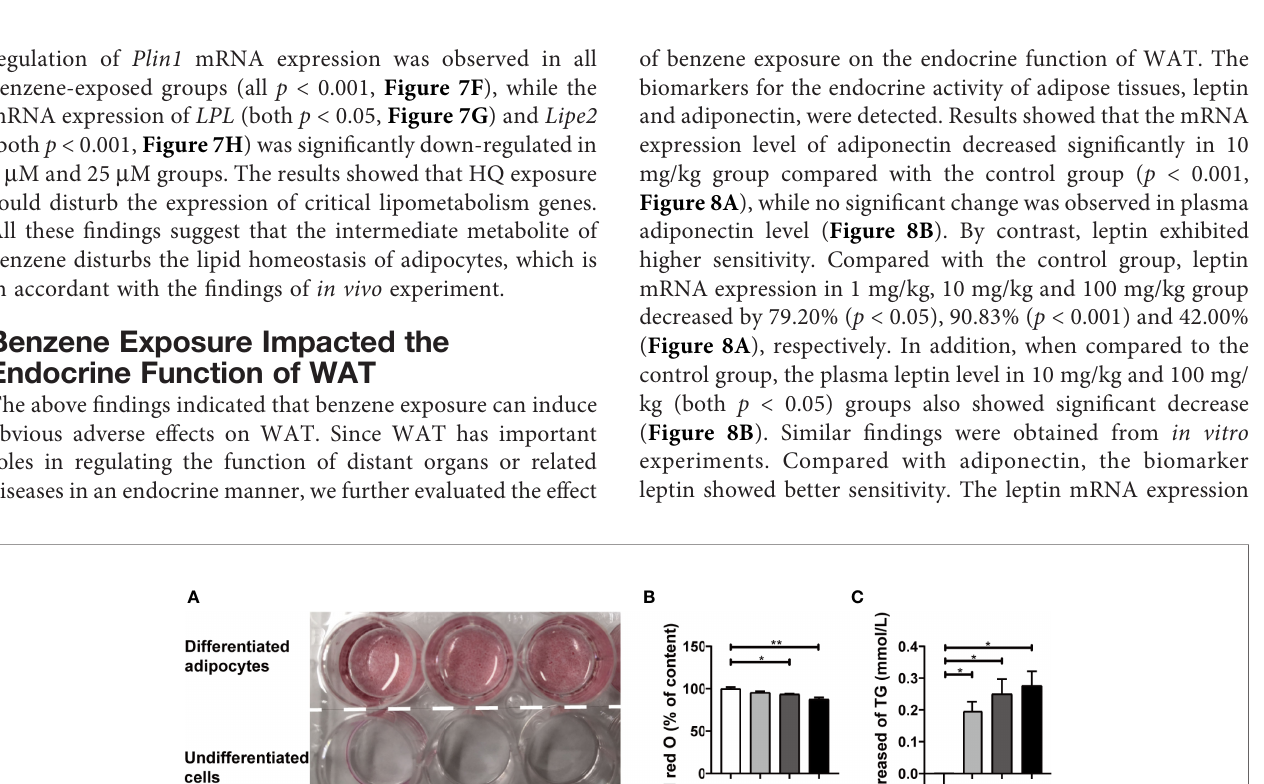
FIGURE 5 | Effect of benzene on mRNA levels of lipid metabolism genes in epididymal white adipose tissue (eWAT). Adult male C57BL/6J mice were exposed to benzene at doses of 0, 1, 10 and 100 mg/kg for 4 weeks. The mRNA expression of genes involved in lipogenesis (A – E) and lipolysis (F – H) were examined in eWAT after benzene exposure. Data are presented as mean ± SD (n = 3-6) and one way ANOVA were performed; * p < 0.05, ** p < 0.001 (compared to the control